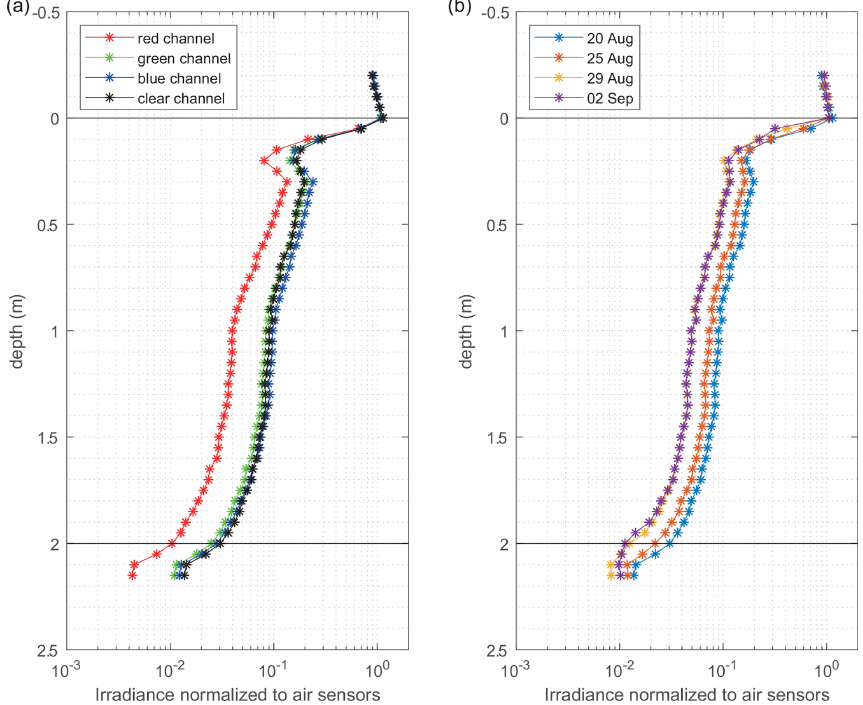
Figure 5. Vertical profiles of sideward planar irradiance through sea ice. (a) Irradiance decay in the four spectral channels shortly after deployment on 20 August 2018. (b) Temporally increasing light attenuation for the clear channel from 20 August to 2 September. Black lines indicate the interfaces between air, ice and ocean.